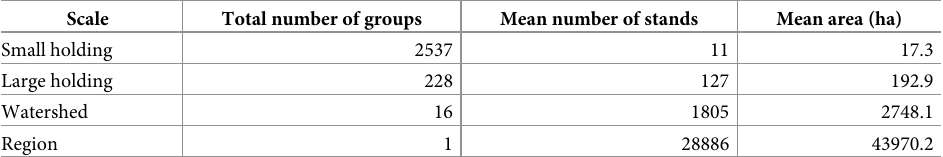
Table 2. Characteristics of planning regions. Total number of groups of stands used as planning regions, mean num- ber of stands in a group, and mean area of a group as defined at the different spatial scales (from Pohjanmies et al.